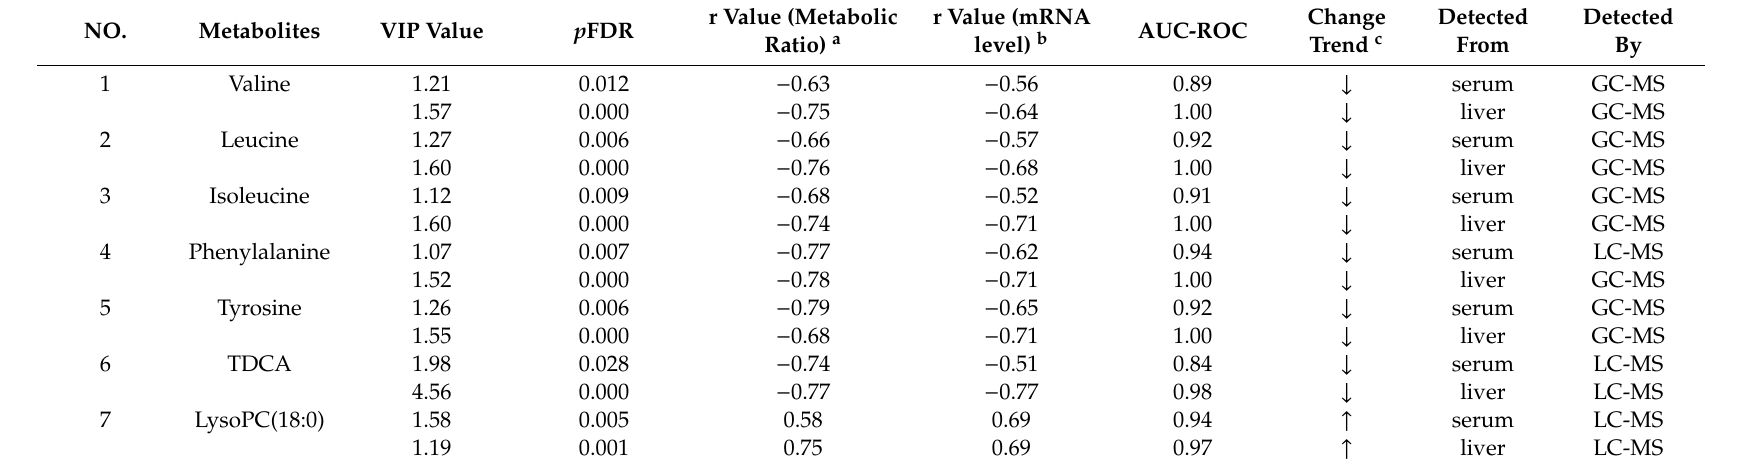
Table 3. List of seven di ff erential metabolites, focalized based on untargeted metabolomic